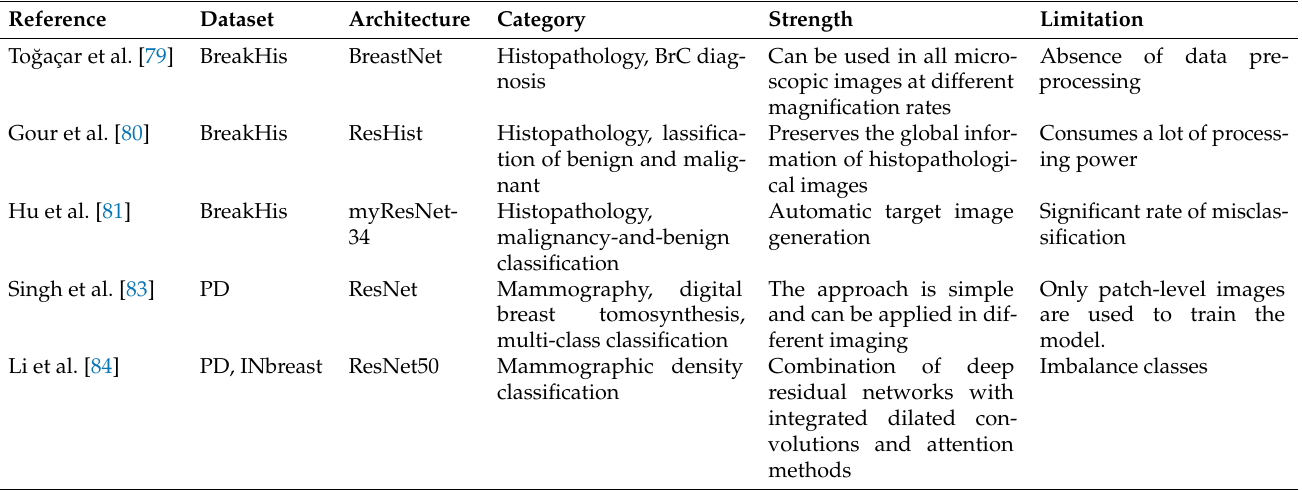
Table 7. State-of-the-art studies based on RL-based